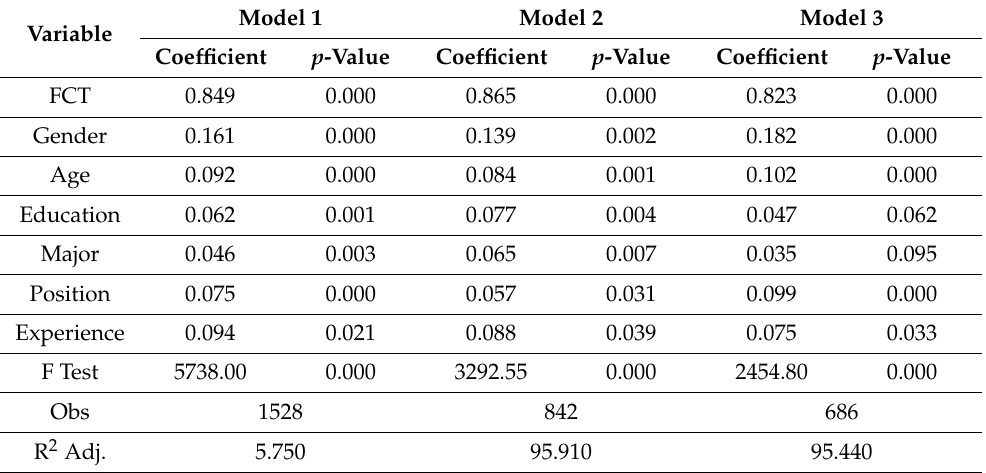
Table 9. The effect of familiarity with blockchain technology on the quality of information.